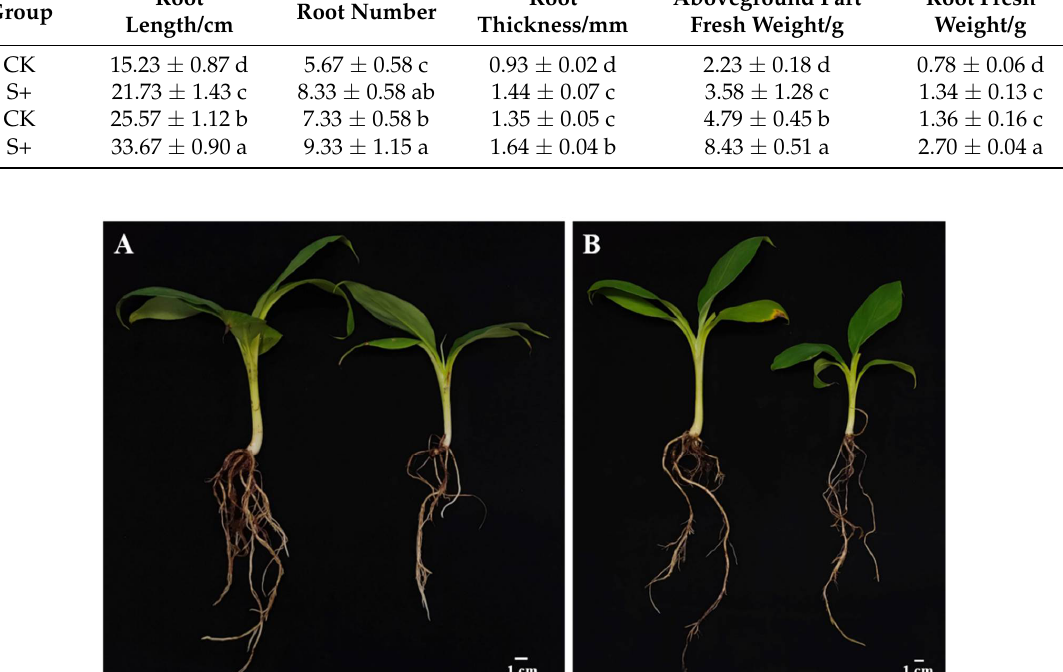
Table 1. Effects of S. indica on the growth indexes of ‘Zhongjiao No.3’ (ZJ3) and ‘Zhongjiao No.4’ (ZJ4) banana seedlings. CK: S. indica non-colonized controls; S+: S. indica colonized banana seedlings. The different letters in the same column represent significant difference among samples at 0.05 level.